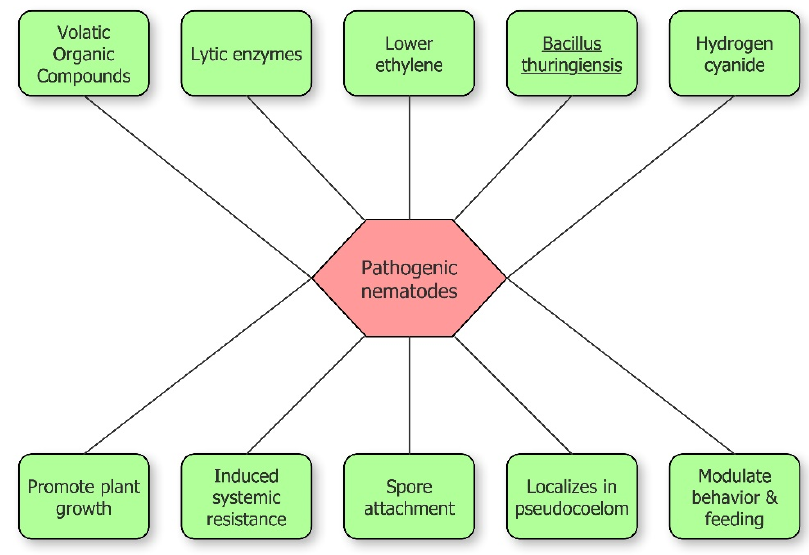
Figure 2. Schematic overview of bacterial inhibition of pathogenic nematodes.